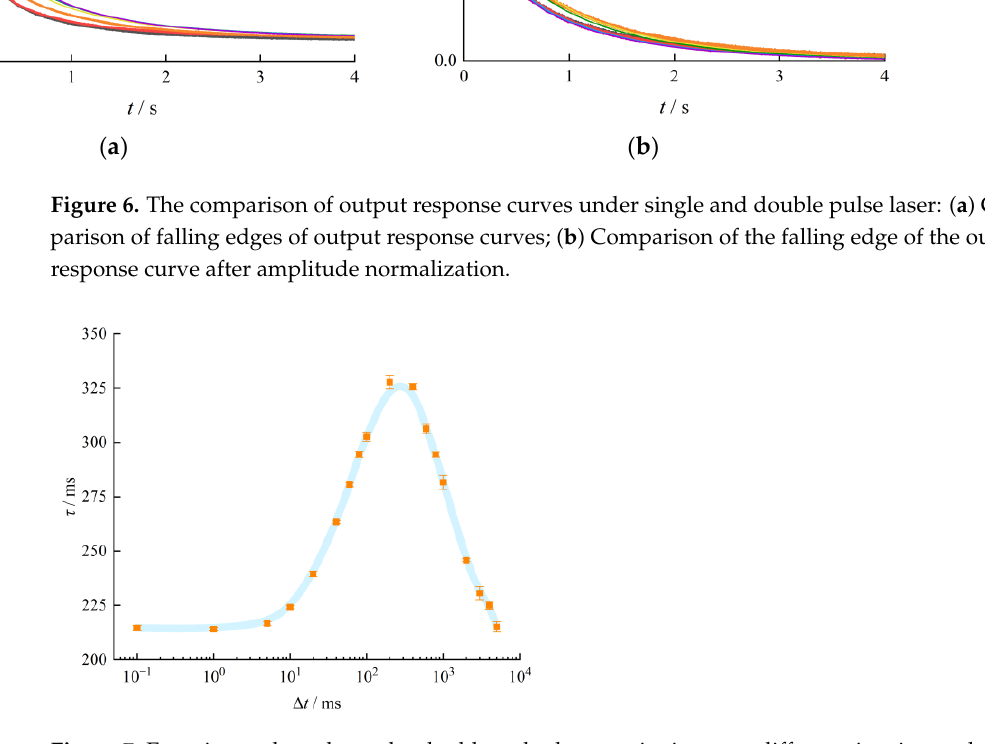
Figure 7. Experimental results under double-pulse laser excitation over different time intervals ( Δ t